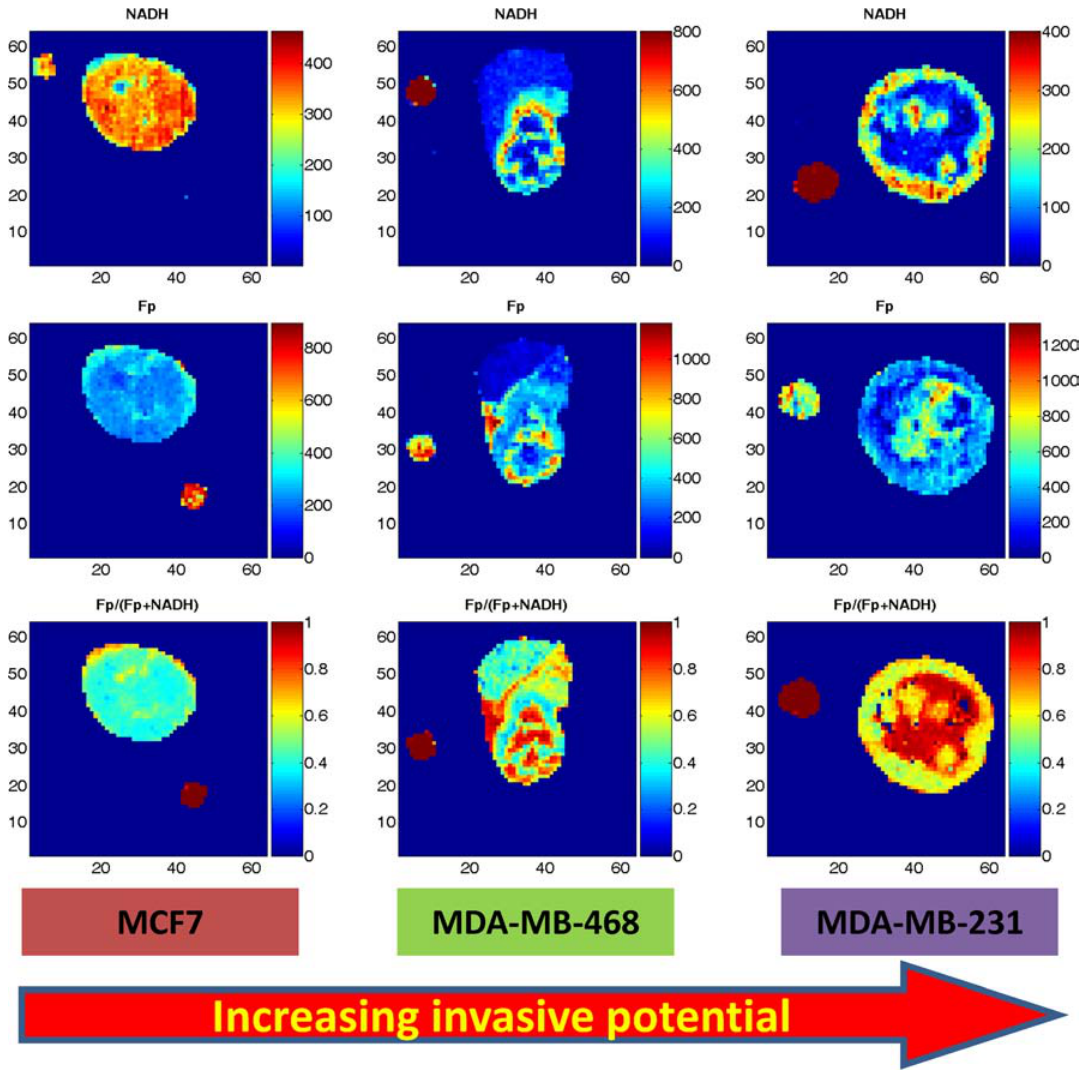
Fig. 3. The typical redox images (NADH, Fp, the Fp redox ratio) of three breast cancer xenografts with increasing invasive potential MCF7 < MDA-MB-468 < MDA-MB-231. The ¯gure is reproduced with permission from Ref.